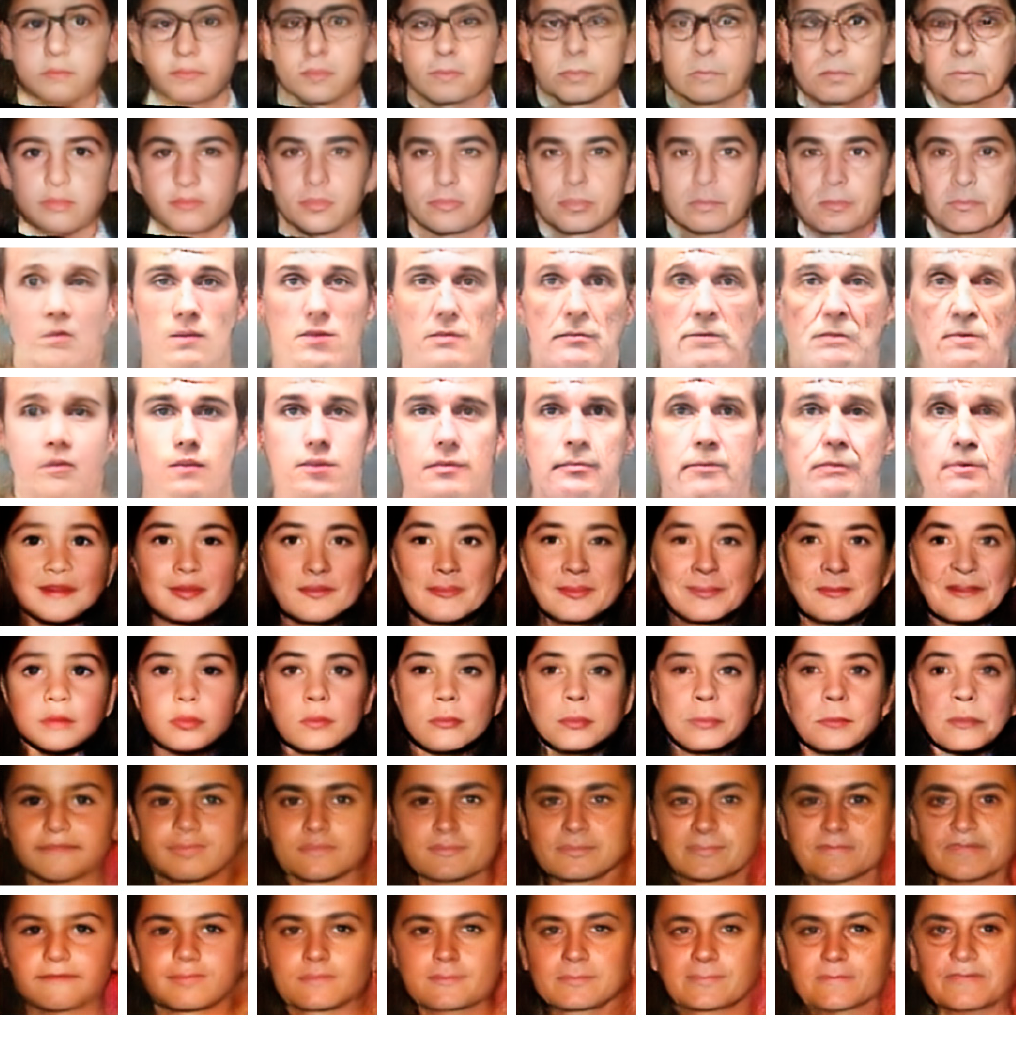
Figure 10. Synthesis diagrams generated from our model.